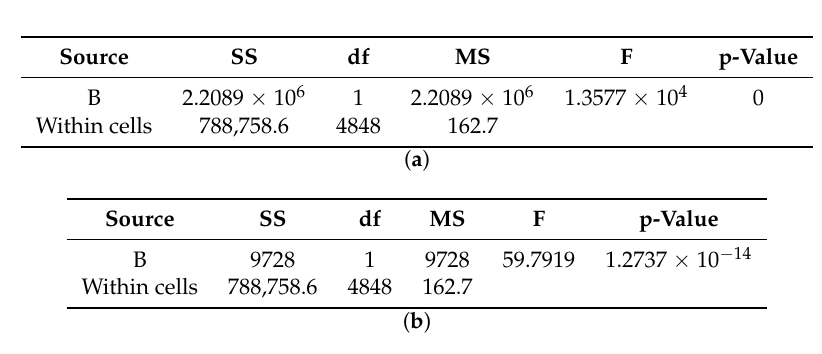
Figure A28. ANOVA tables for the analysis of the effect of factor B (amount of missing observations) on the convergence. ( a ) One-way ANOVA for factor B given C = 1. ( b ) One-way ANOVA for factor B given C = 2.